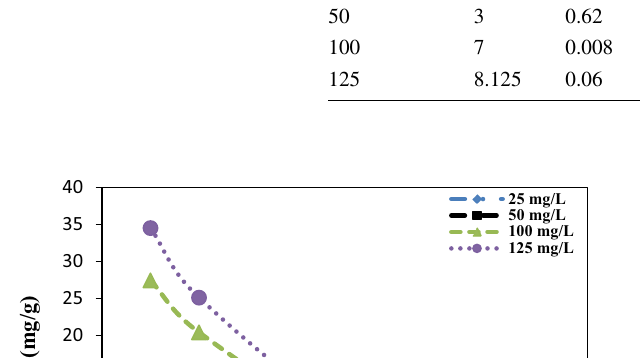
Table 4 The nonlinear adsorption kinetic model constants calculated for the removal of Ni(II) on MWCNTs